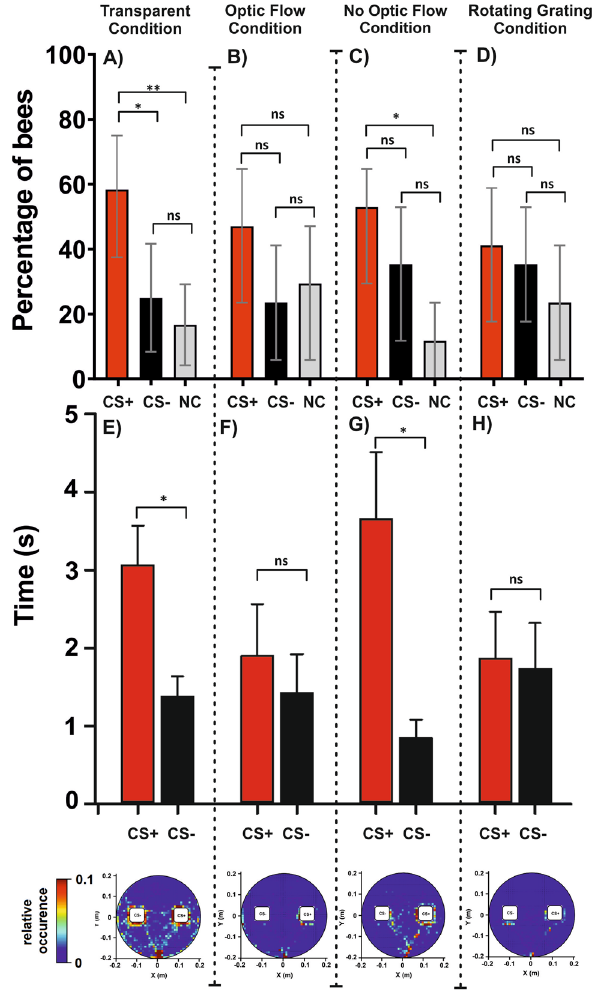
Figure 6. Test performances (1st choice and fixation time) in a color discrimination learning task under four different background conditions. Panels ( A – D) refer to the 1st choice and show the percentage of bees responding to the CS+ (red), to the CS− (black) or not making any choice (NC; gray) during a retention test performed in extinction conditions after a 10-trial training. Error bars indicate 95% confidence intervals. *: p < 0.05; **: p < 0.01; ns: non-significant. ( A ) In the ‘ Transparent Condition ’ (N = 24), the blue and green cuboids were displayed against a dark background. ( B ) In the ‘ Vertical Grating—Optic Flow Condition ’ (N = 17), the cuboids were presented against a red-and-black vertical grating, which was coupled to the bee’s movements (closed-loop conditions). ( C ) In the ‘ Vertical Grating—No Optic Flow Condition ’ (N = 17), the cuboids were displayed against the same red-and-black grating but motion cues from the background were suppressed by keeping it constantly fixed to the bee’s gaze. ( D ) In the ‘ Rotating Vertical Grating Condition ’ (N = 17), the cuboids were shown against the same red-and-black grating, which was rotated counterclockwise around the virtual arena at a constant speed, thus generating a constant optic flow even when the bee did not move. Panels ( E – H ) refer to the fixation time, i.e. the time spent fixating either the CS+ or the CS− during the test. Bars represent the mean fixation time. Error bars indicate the standard error f the mean. *: p < 0.05; ns: non-significant. ( E ) ‘ Transparent Condition ’ (N = 24). ( F ) ‘ Vertical Grating—Optic Flow Condition ’ (N = 17). G) ‘ Vertical Grating—No Optic Flow Condition ’ (N = 17). ( H ) ‘ Rotating Vertical Grating Condition ’ (N = 17). The bottom row shows the heat map corresponding to each condition. Each heat map shows the cumulative coordinates occupied by the bees under each background condition during the test. Coordinates were binned into 1 cm 2 . Warmer colors depict locations more frequently occupied (see color bar). The highest frequency is cut down to 10% of the maximum on the color bar. The rewarded stimulus was placed arbitrarily on the